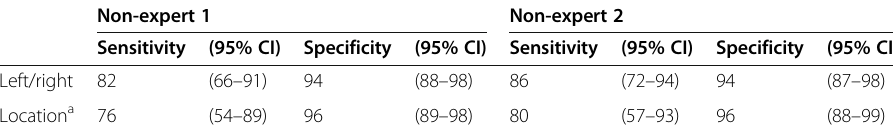
Table 5 Sensitivity and specificity of non-experts, using the expert as the gold standard